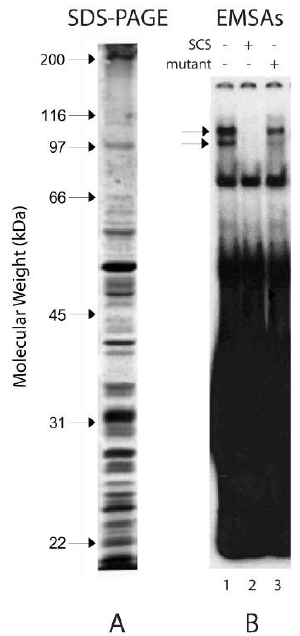
Figure 1. Yeast protein complexes bind specifically to the human p53 super consensus sequence. A . Proteins used in the gel shift assays were extracted from nuclear preparations from fresh cells grown to the early stationary phase in liquid YPAD medium. Sixty µ g of protein were loaded and run on 10% SDS-PAGE gels. Molecular weights of nuclear proteins were determined by molecular weight standards run in adjacent lanes. B . Electrophoretic Mobility Shift Assays (EMSAs) of 5.1 µ g of protein hybridized to the 32 P-radiolabeled oligonucleotide (0.15 pmole) containing the p53 synthetic DNA-consensus sequence (SCS). Lane 1: no competitor. Lane 2: competition with 15 pmole (100x excess) of unlabeled p53 SCS oligonucleotide. Lane 3: competition with 15 pmole (100x excess) of unlabeled mutant RGC (mtRGC) oligonucleotide. The gel was run until the bromophenol blue dye reached two inches from the bottom of the chamber. Bands that contain proteins that specifically bound to DNA in the complexes are indicated with two arrows.